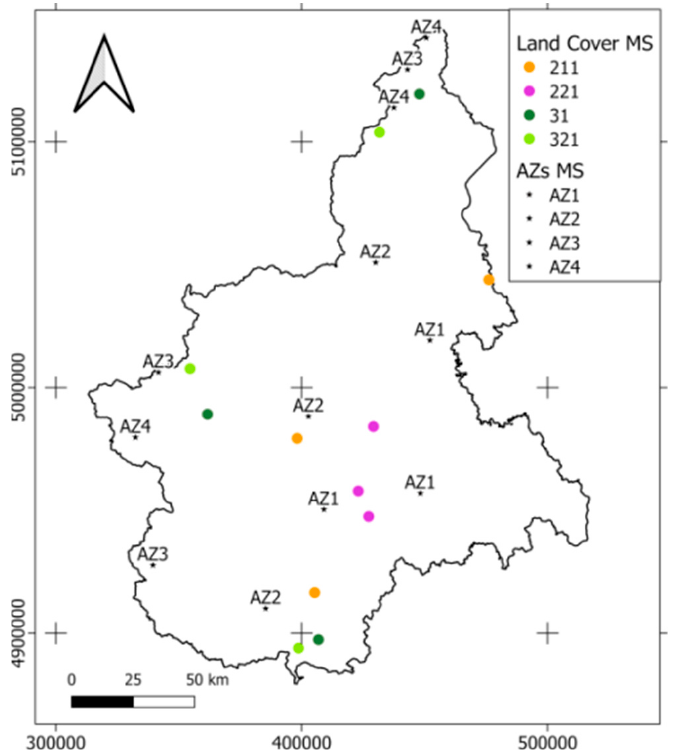
Figure 2. Land Cover and altitudinal zones (AZs) Meteorological stations (Reference frame: WGS 84/UTM zone 32N, EPSG: 32632).